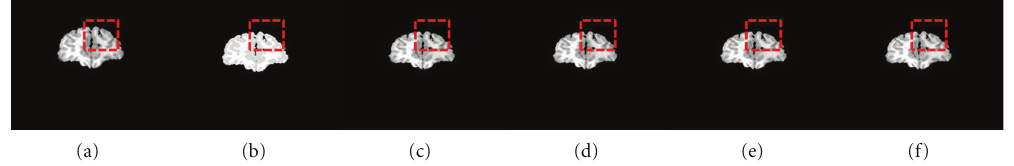
Figure 3: Comparison of the segmentation results on a simulated brain MR image. (a) original T1-weighted image, (b) manual class labeling of gray matter (GM) and white matter (WM) slice regions; results obtained with (c) FCM, (d) MSFCM, (e) FCMT, (f) SFCM, and (g) the proposed approach.